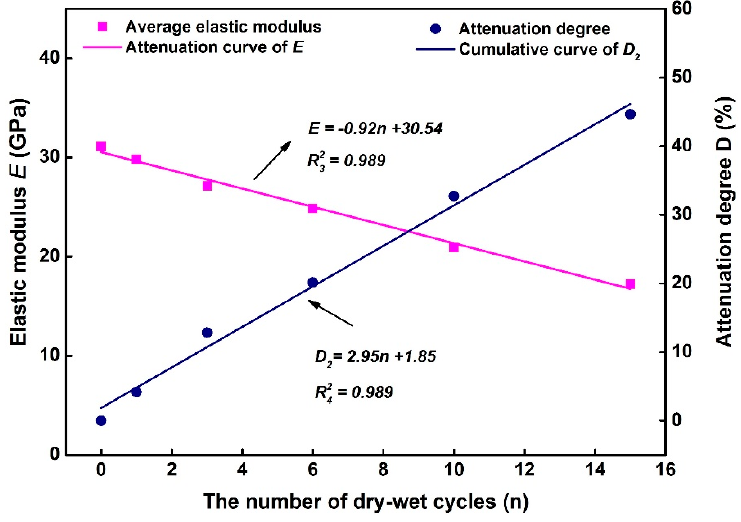
Figure 7. The changes of average elastic modulus of rock and its degree of attenuation with the number of dry-wet cycles.